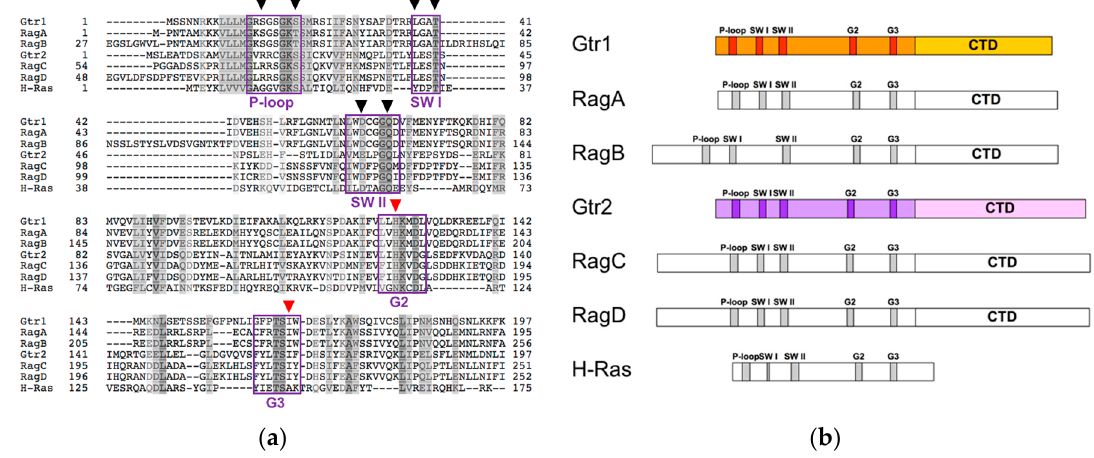
Figure 1. ( a ) Alignment of the G domain sequences of budding yeast (Gtr1 and Gtr2) and human (RagA, RagB, RagC, and RagD) Rag GTPases together with the G domain of human Ras (H-Ras). Conserved residues are highlighted in grey. Boxes denote typical GTPase sequence motifs (see text). Arrow heads mark important residues discussed in the text. Red arrow heads highlight typical Rag GTPase residues; ( b ) Schematic representation of the sequences of yeast and human Rag GTPases together with H-Ras. The sequences were aligned with respect to their G domains.